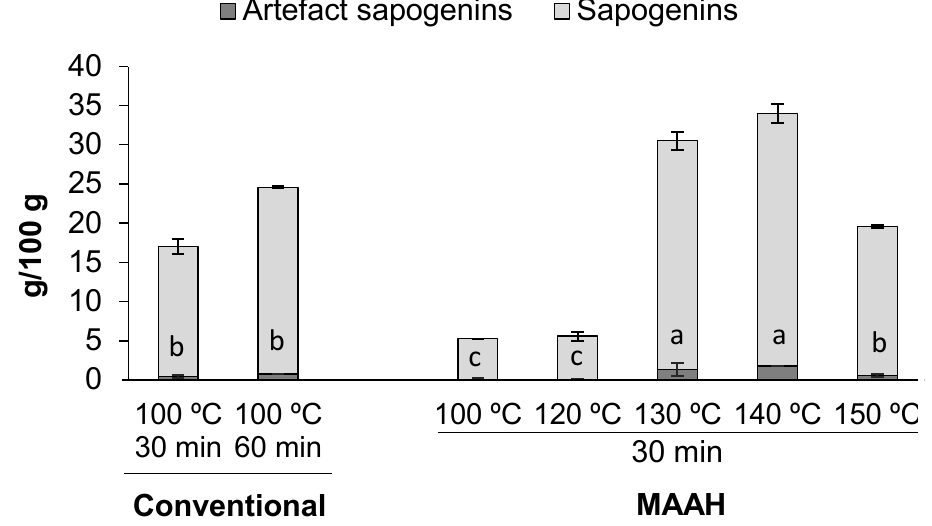
Figure 2. Sapogenin and artifact content (g/100 g) of sapogenin-rich extracts obtained by conventional hydrolysis and microwave-assisted acid hydrolysis (MAAH) at different temperatures. Standard deviations are indicated by error bars. Mean values with different letters (a–c) are significantly different ( p ≤ 0.05).